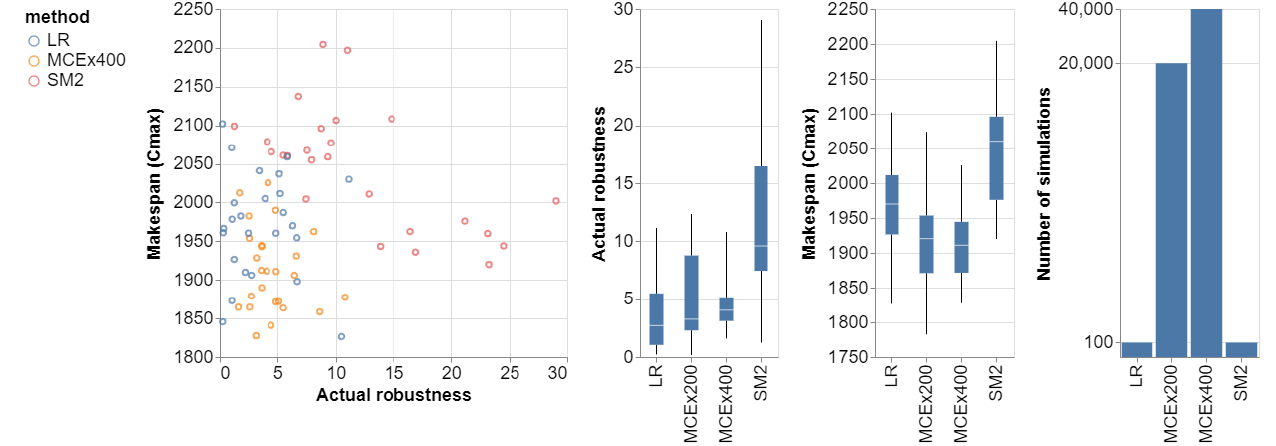
Figure 6. Comparing RS s generated by LR , SM 2 and MCE integrated into a SARS